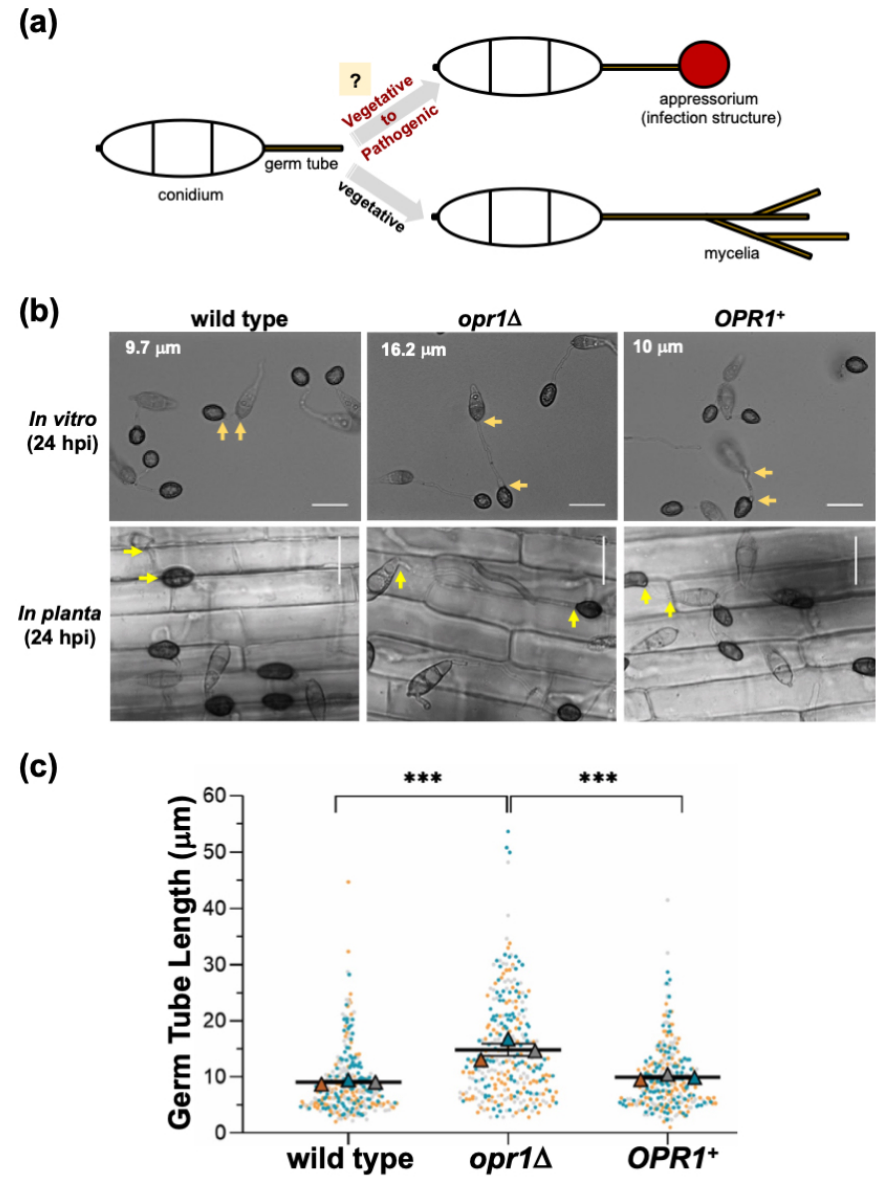
Figure 1. Loss of OPR1 results in extended germ tube growth prior to appressorium initiation in M. oryzae . ( a ) Schematic representation of the critical steps involved in infection-related morphogenesis in conidial germ tubes of M. oryz ae in response to inductive host environmental cues. The absence of such host factors causes cessation of this developmental switch and continuation of vegetative growth as mycelia without the formation of appressoria. ( b ) Bright-field micrographs showing comparative analysis of germ tube growth and appressorium formation in conidia from wild-type, opr1 Δ , or the complemented opr1 Δ ( OPR1 + ) M. oryzae strains inoculated on artificial inductive surface (in vitro) or rice sheath (in planta). Compared to the WT or Complemented strain, germ tubes in opr1 Δ mutant were significantly longer. Arrows demarcate the germ tube length in each panel. Scale bar equals 10 μ m. ( c ) Graphical representation of the quantification of the germ tube length in the indicated M. oryzae strains. Each dot represents the individual data derived from three independent biological repeat experiments ( n = 300 conidia for each sample). The overlapping triangles represent the means of each repeat in line with dots of the same colour. Two-tailed t -test was applied for the comparisons, *** p <0.001. Fresh conidia were inoculated on hydrophobic cover glass or rice sheath, and measurements were performed at 24 hpi.